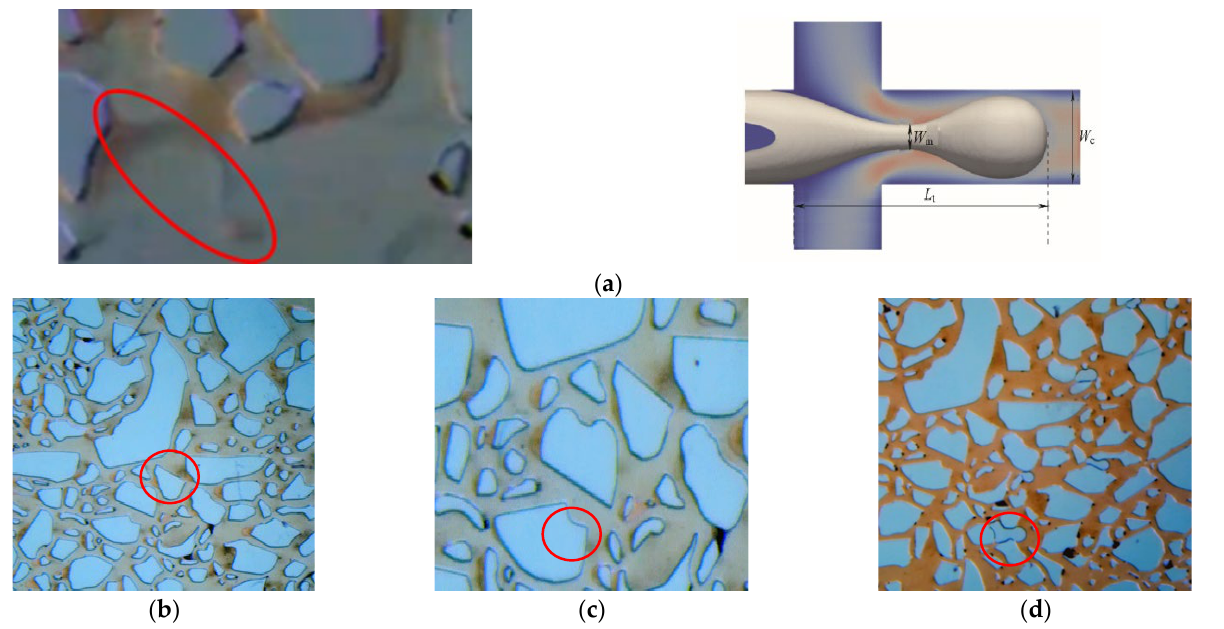
Figure 6. Oil mobilization: ( a ) Flow aggregation; ( b ) CO 2 funnel extraction of crude oil; ( c ) Plume stepwise miscibility; ( d ) Swelling effect .